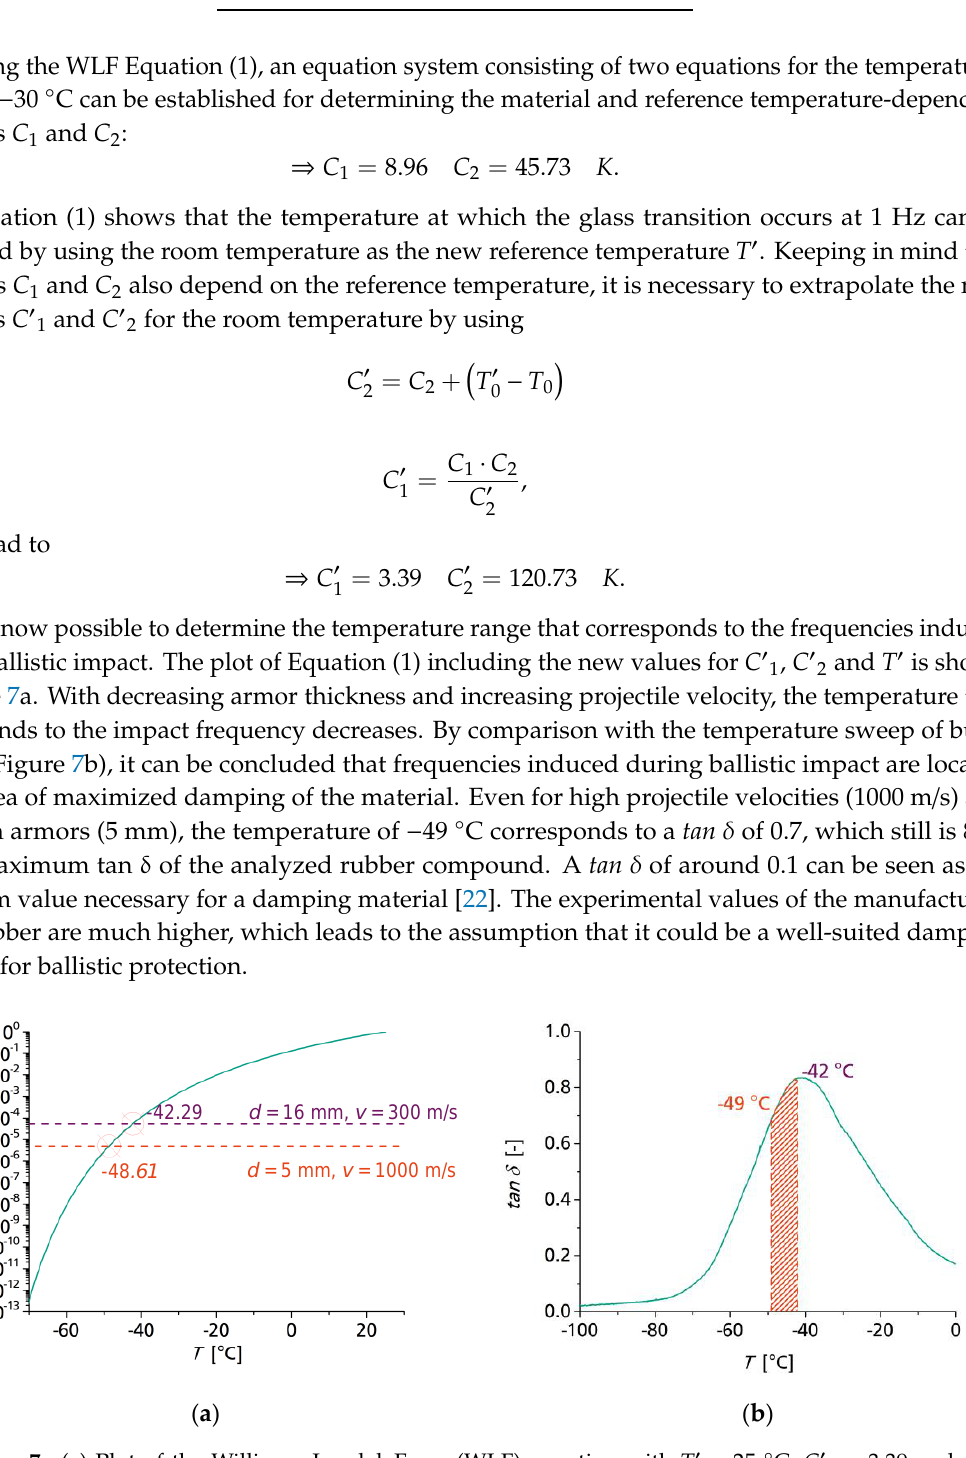
Figure 7. ( a ) Plot of the Williams–Landel–Ferry (WLF) equation with T′ = 25 °C, C′ 1 = 3.39 and C′ 2 = 120.73 K. ( b ) Temperature sweep of butyl rubber with the corresponding temperature range for impact-induced frequencies.